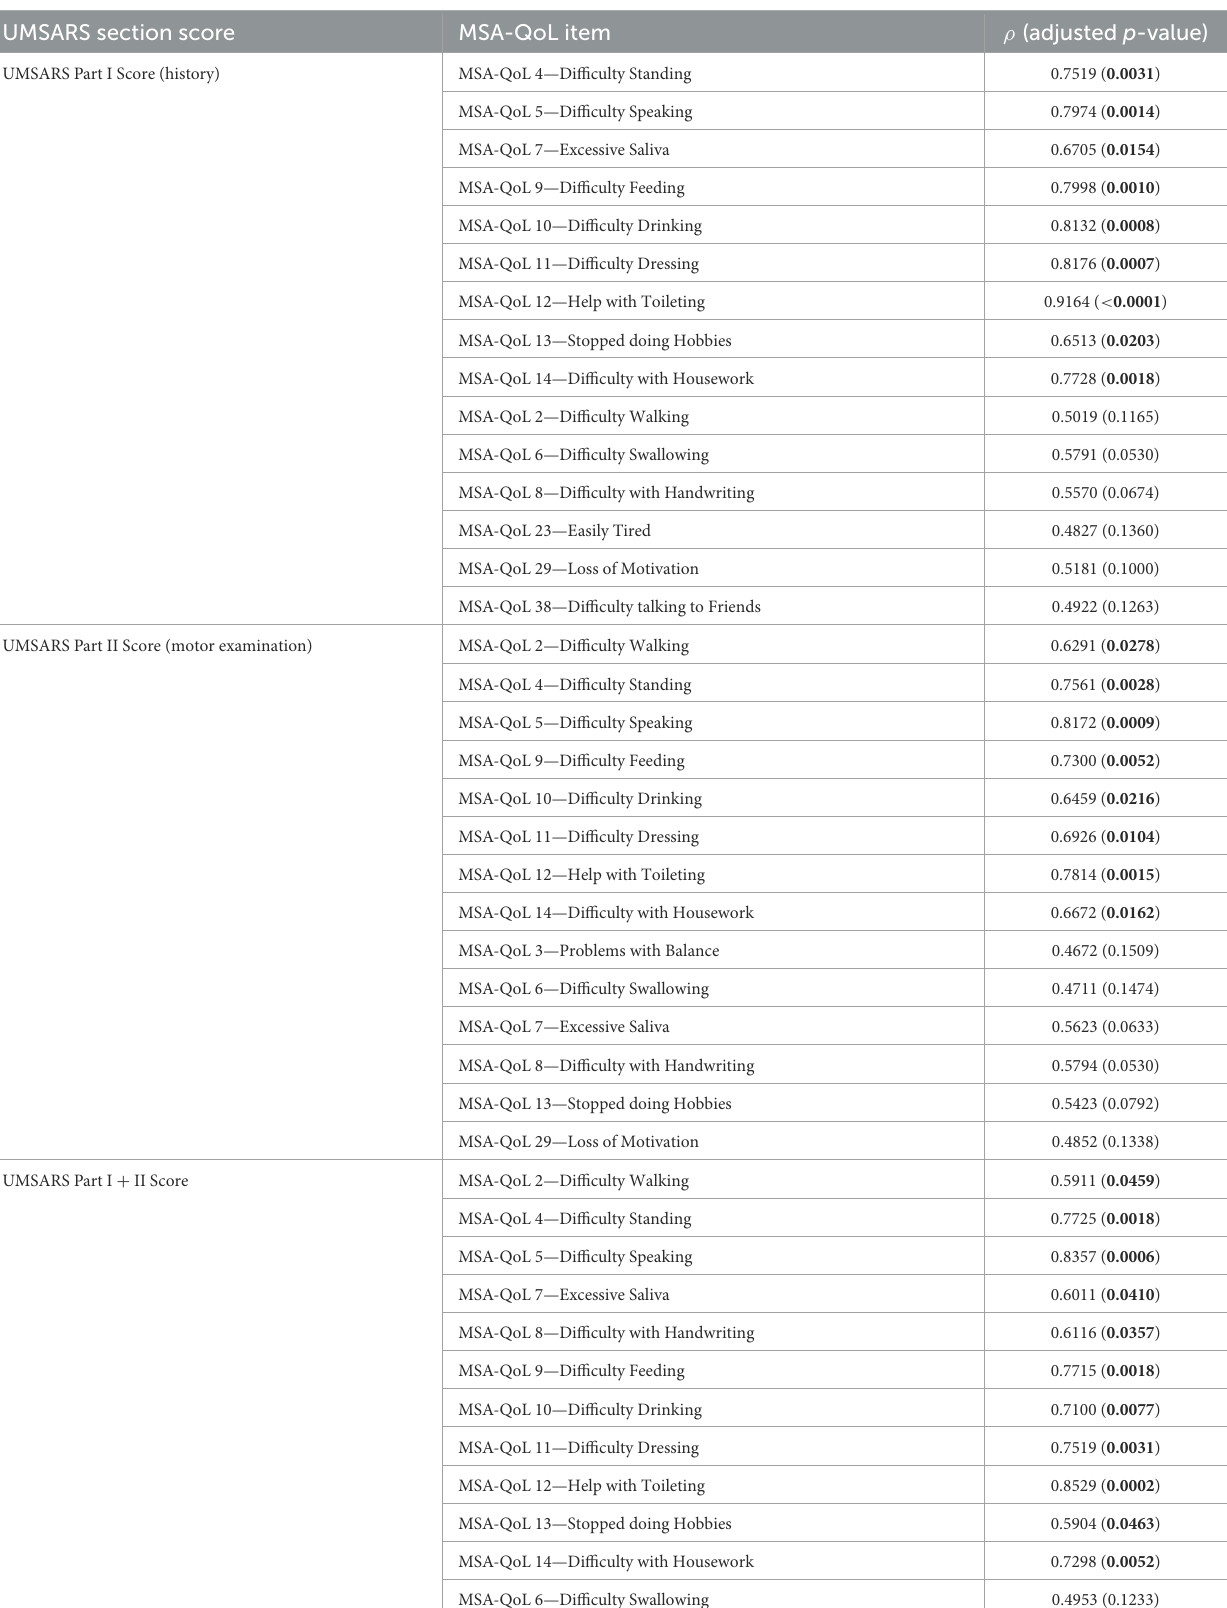
TABLE 2 Correlations of UMSARS section scores with individual MSA-QoL